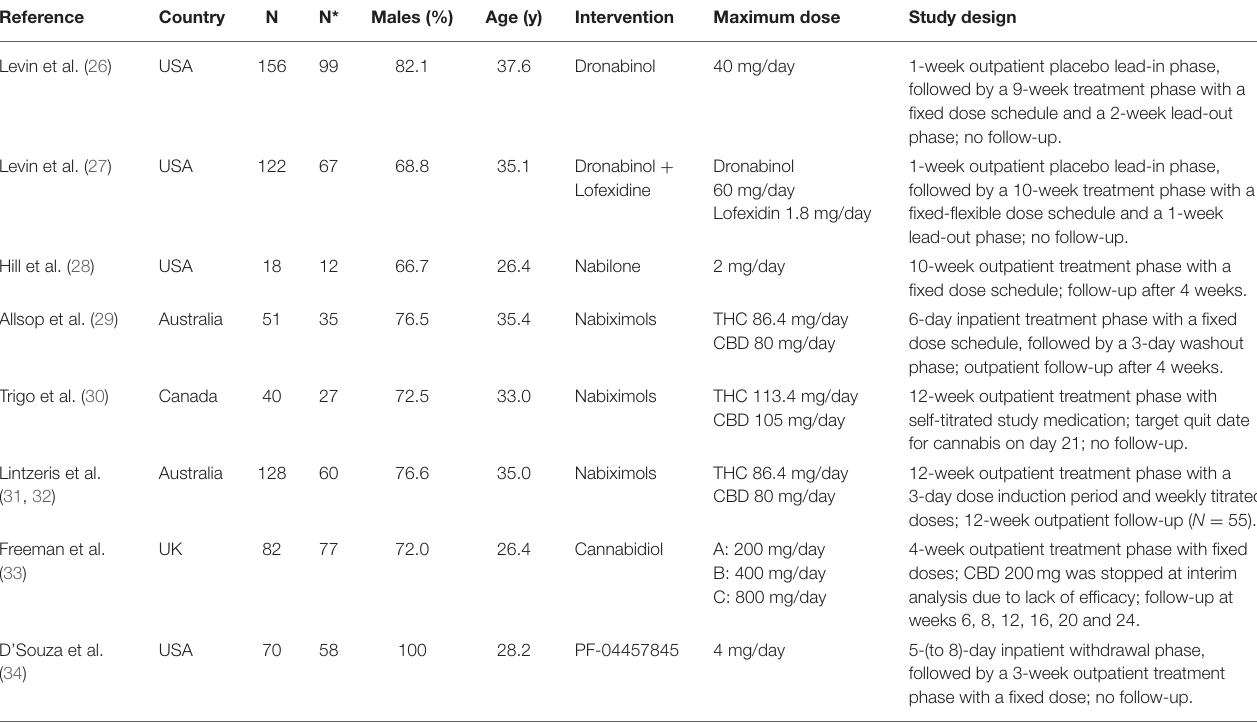
TABLE 2 | Study characteristics. Reference